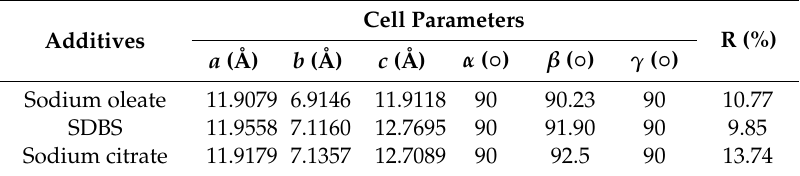
Table 1. Spectral fitting of X-ray diffraction (XRD)